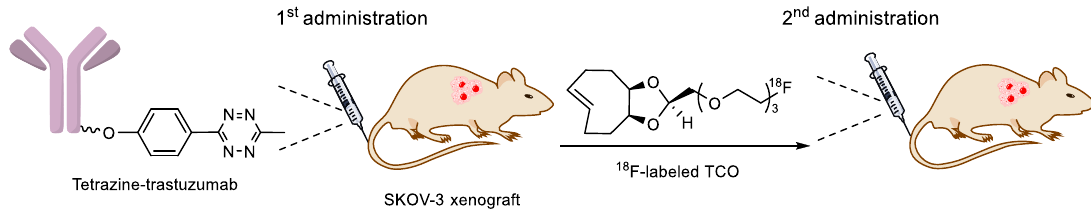
Figure 16. Two-step pre-targeting strategy using 18 F-labeled TCO.